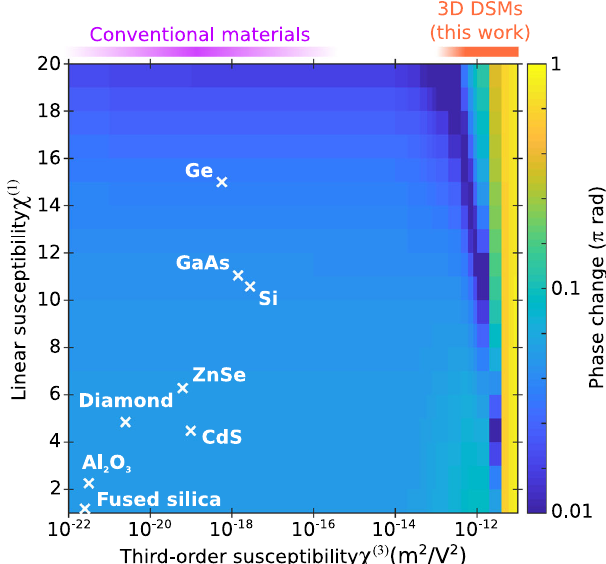
Fig. 2 Extreme subwavelength phase- fl ip of the induced current in highly nonlinear materials. The colormap shows the phase shift in the 3rd harmonic current for a 2500 nm-thick, non-dispersive dielectric fi lm as a function of its linear and third-order susceptibilities, χ (1) and χ (3) respectively, driven by an external fi eld of 10 MV/m. We fi nd that the